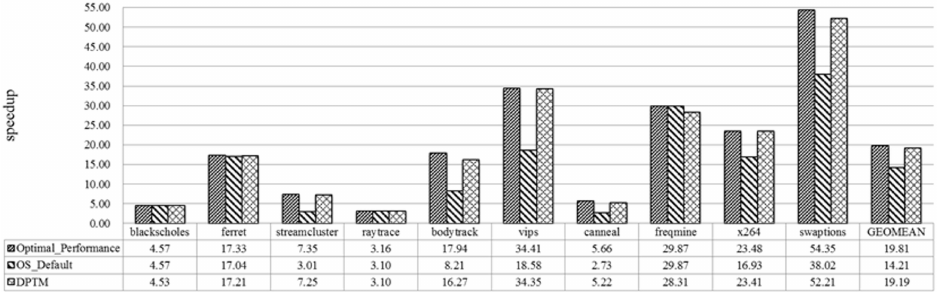
Figure 6. Performance speedup comparison.